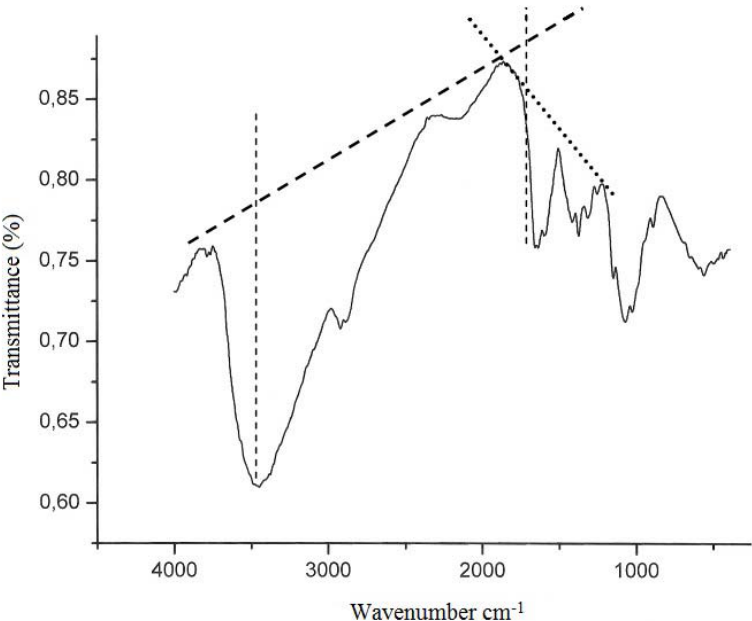
Figure 1. Infrared spectra of chitosan obtained from biomass of M. circinelloides UCP 050 and lignes of degree of acetylation (DD) determined according to Baxter et al.